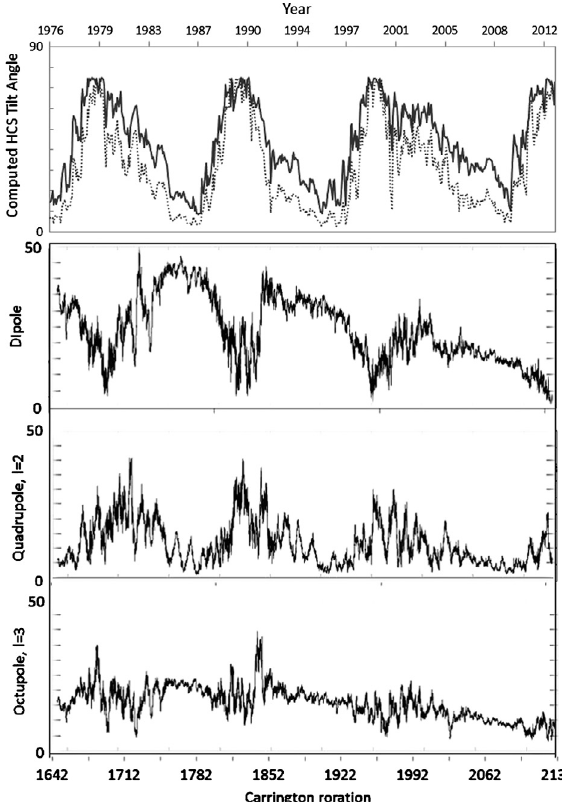
Figure 1. Top panel: computed maximum inclination of the heliospheric current sheet illustrating the flip of the global magnetic field for 1976–2012 (Carrington rotations 1642–2132). The solid line is the simulation with the classic PFSS model using the line-of- sight boundary condition in the photosphere including significant polar field correction; the dashed line is the model with higher source surface radius R S = 3.25, it uses a radial boundary condition at the photosphere without polar field correction. Bottom panel: the total strength of the first three multipole components (dipole, quadrupole, and octupole, from top to bottom respectively) of the solar magnetic field during Carrington rotations 1642–2132. The data was provided by the Wilcox Solar Observatory